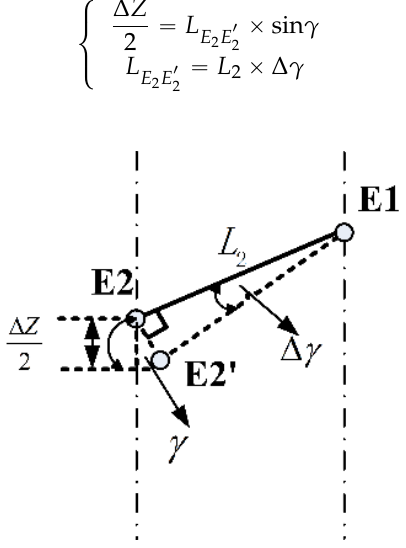
Figure 10. Approximation model.